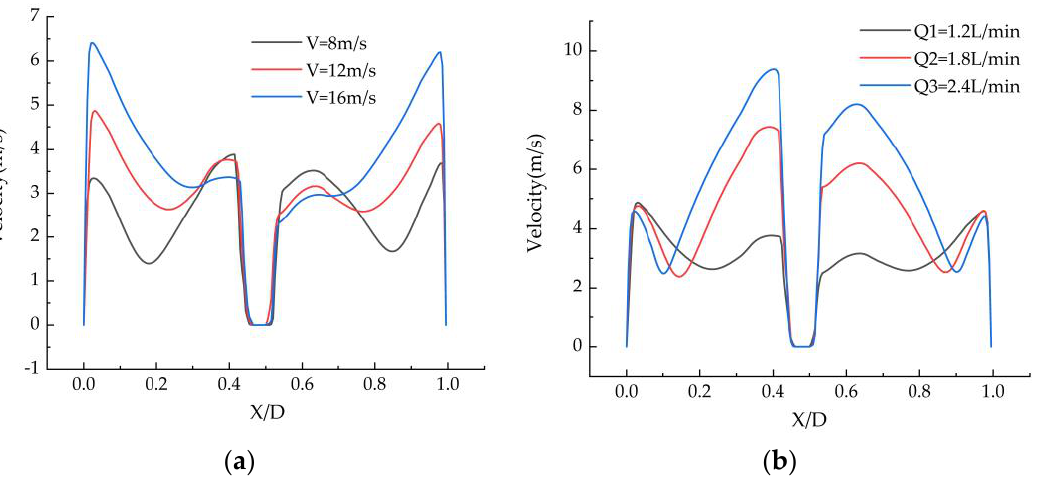
Figure 3. Distribution of the droplet velocity at Z = 850 mm for ( a ) different gas velocities and ( b ) different spray volumes.